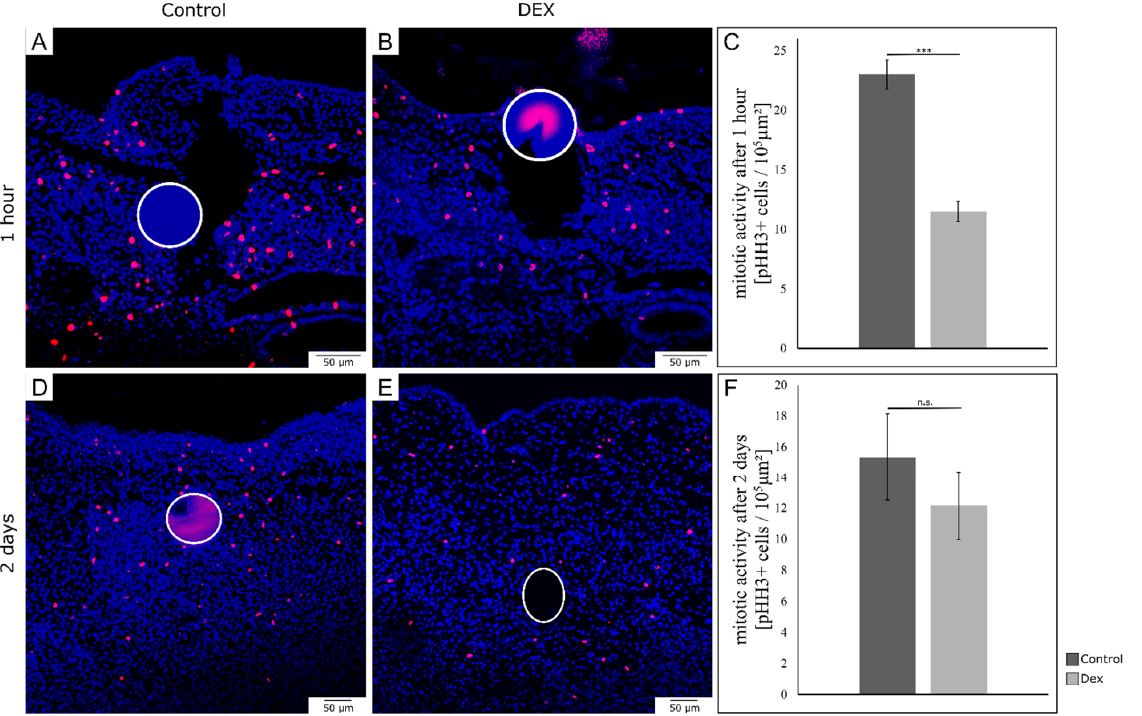
Figure 5. Mitotic activity in bead-implanted wounds. The images show the comparison of mitotic activity in the bead-implanted wound areas using immunohistochemistry for phospho-Histone H3. ( A ) shows a control wound after one hour. ( B ) shows a dex wound after one hour. ( C ) shows the quantification of mitotic activity after one hour. Note the significant reduction of mitotic cells in dex wounds after one hour of wounding (control: n = 3; dex: n = 3). *** p < 0.01. ( D ) shows a control wound after two days. ( E ) shows a dex wound after two days. ( F ) shows the quantification of mitotic activity after two days hour. After two days the mitotic activity was insignificantly reduced (control: n = 3; dex: n = 3). All data are presented as mean ± SE. n .s. = not significant.